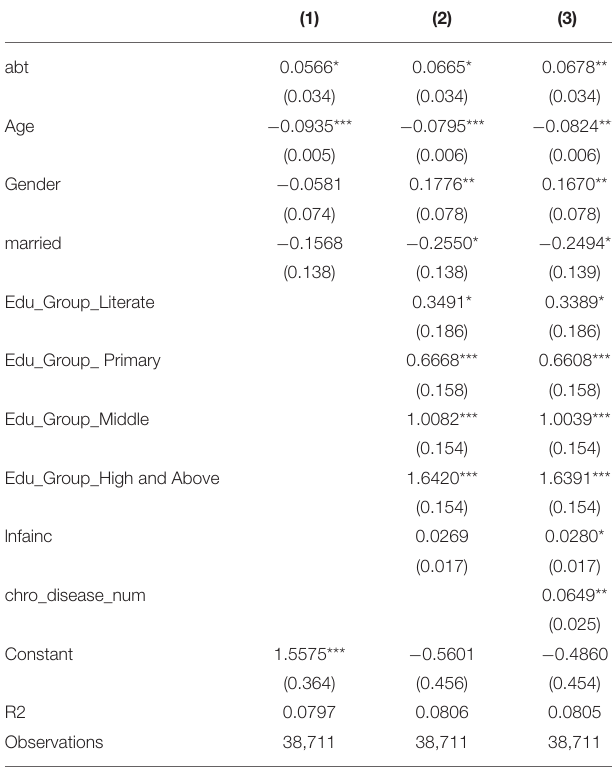
TABLE 3 | The impact of abnormal temperature on the demand of commercial medical